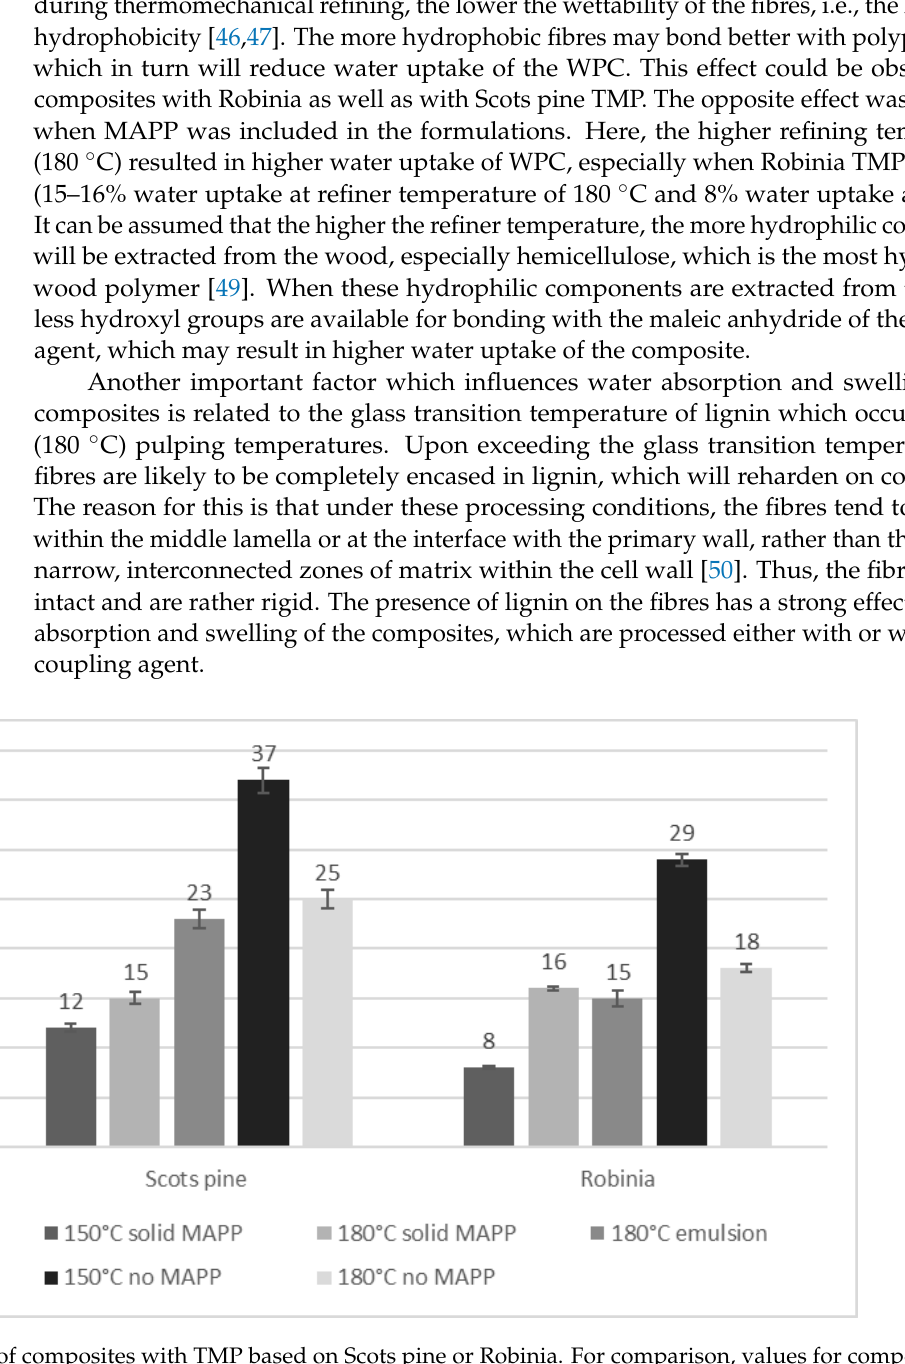
Figure 6. Water uptake of composites with TMP based on Scots pine or Robinia. For comparison, values for composites with wood flour (softwood) were 7% including MAPP (solid) and 31% excluding MAPP.